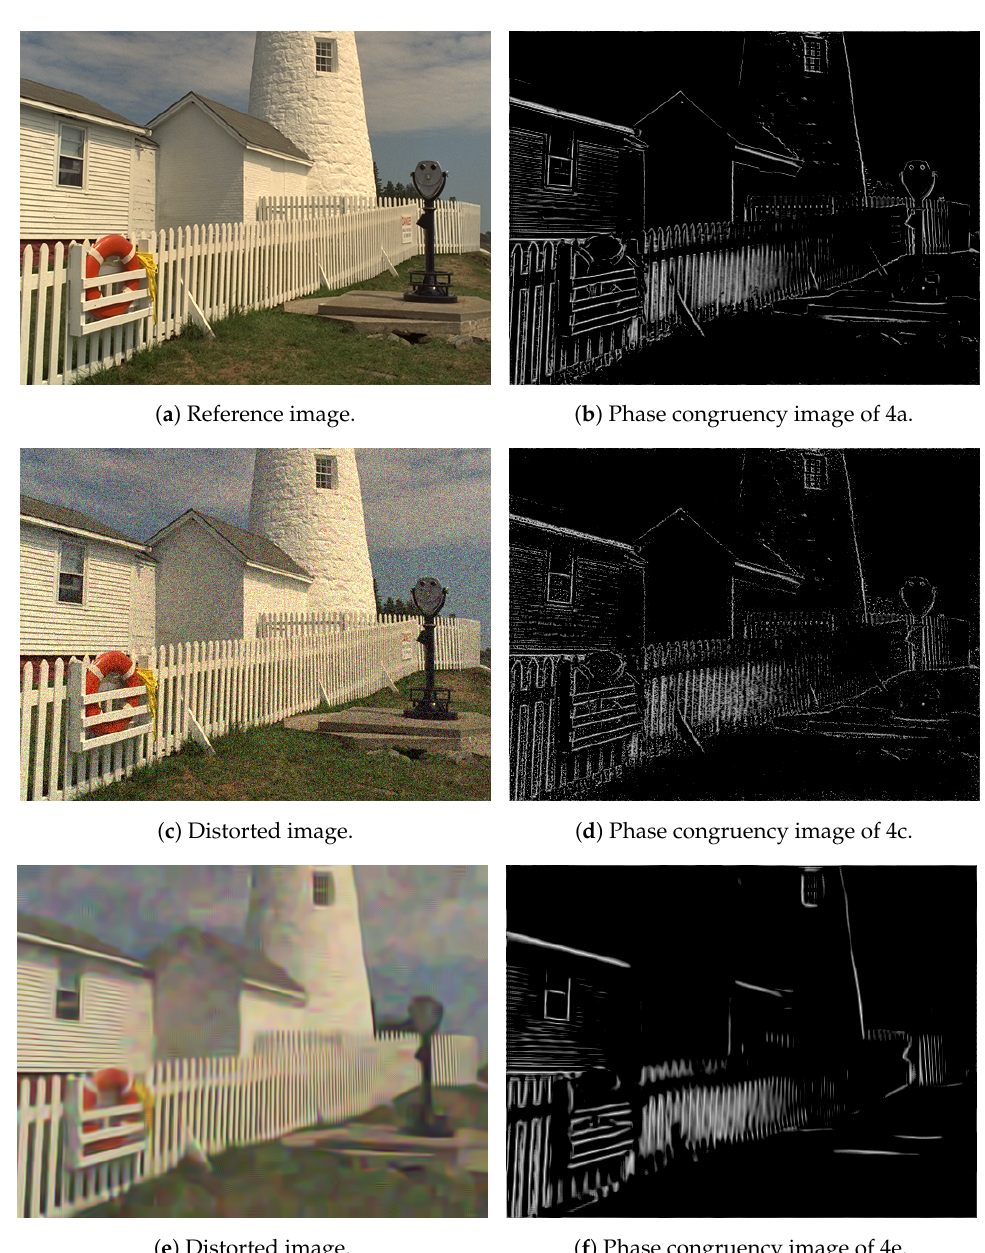
Figure 4. Illustration of phase